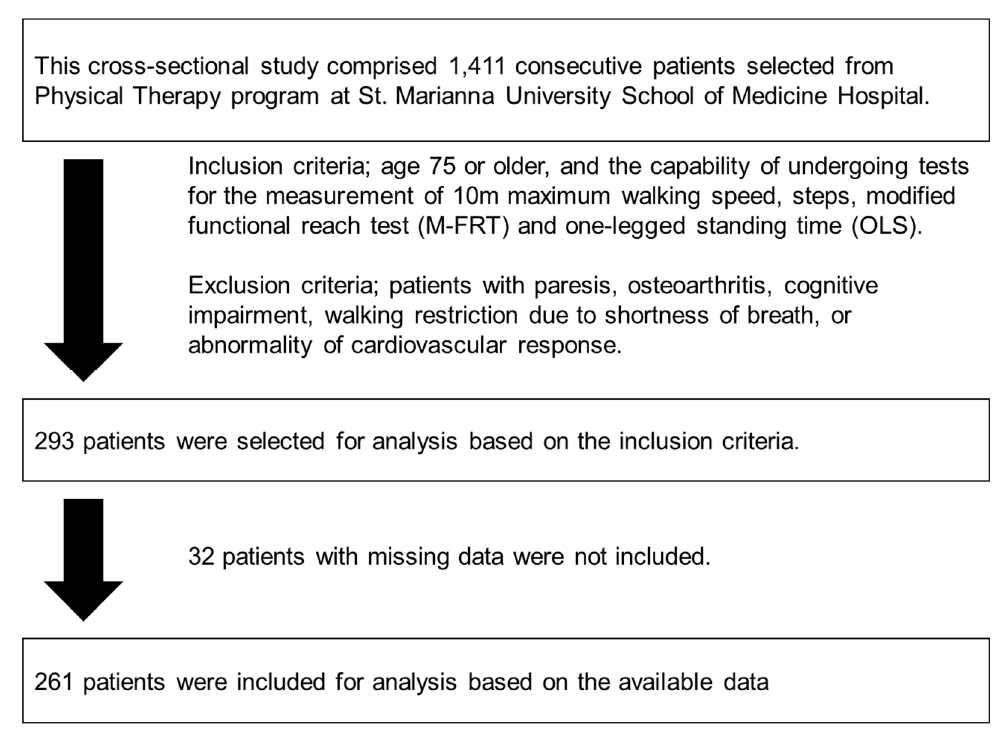
Figure 1. Diagram of the patient selection process.